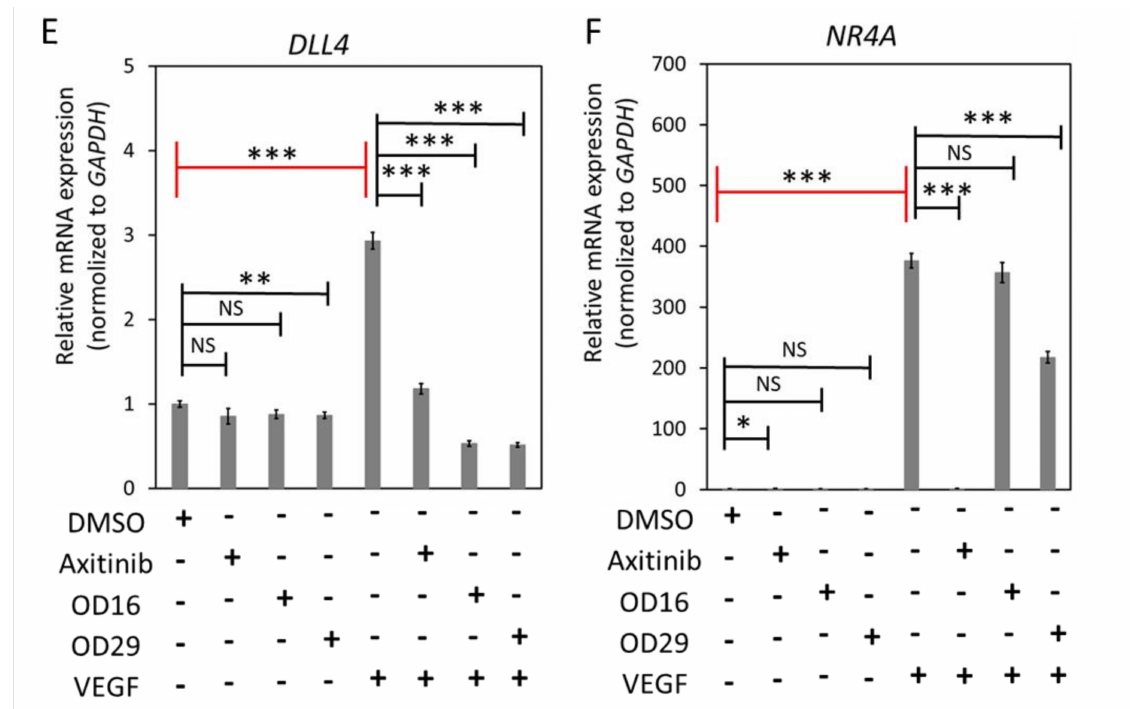
Figure 3. OD29 antagonizes VEGF-induced pERK MAP kinase in HUVECs. ( A – C ) Western blot analysis of dose-dependent effects of small molecule VEGFR kinase inhibitor Axitinib ( A ), OD16 ( B ), OD29 ( C ), or vehicle control (DMSO) on VEGF (40 ng/mL)-induced VEGFR and ERK MAP kinase phosphorylation in HUVECs. ( D ) Quantification of the Western blot analysis of VEGF-induced p-ERK MAP kinase. Tubulin was used as a loading control. The results from three biologically independent Western blot experiments were integrated. The results are expressed as mean ± SD. ( E , F ) RT-qPCR analysis of the effects of Axitinib, OD16, OD29 (0.5 µ M), or vehicle control (DMSO) on VEGF (40 ng/mL)-induced DLL4 ( E ) and NR4 A ( F ) mRNA expression in HUVECs. Results from three biologically independent experiments are shown as mean ± SD. * p < 0.05, ** p < 0.005, *** p < 0.001. NS, not significant. Complete Western Blot images of subfigures ( A – C ) are available in Figure